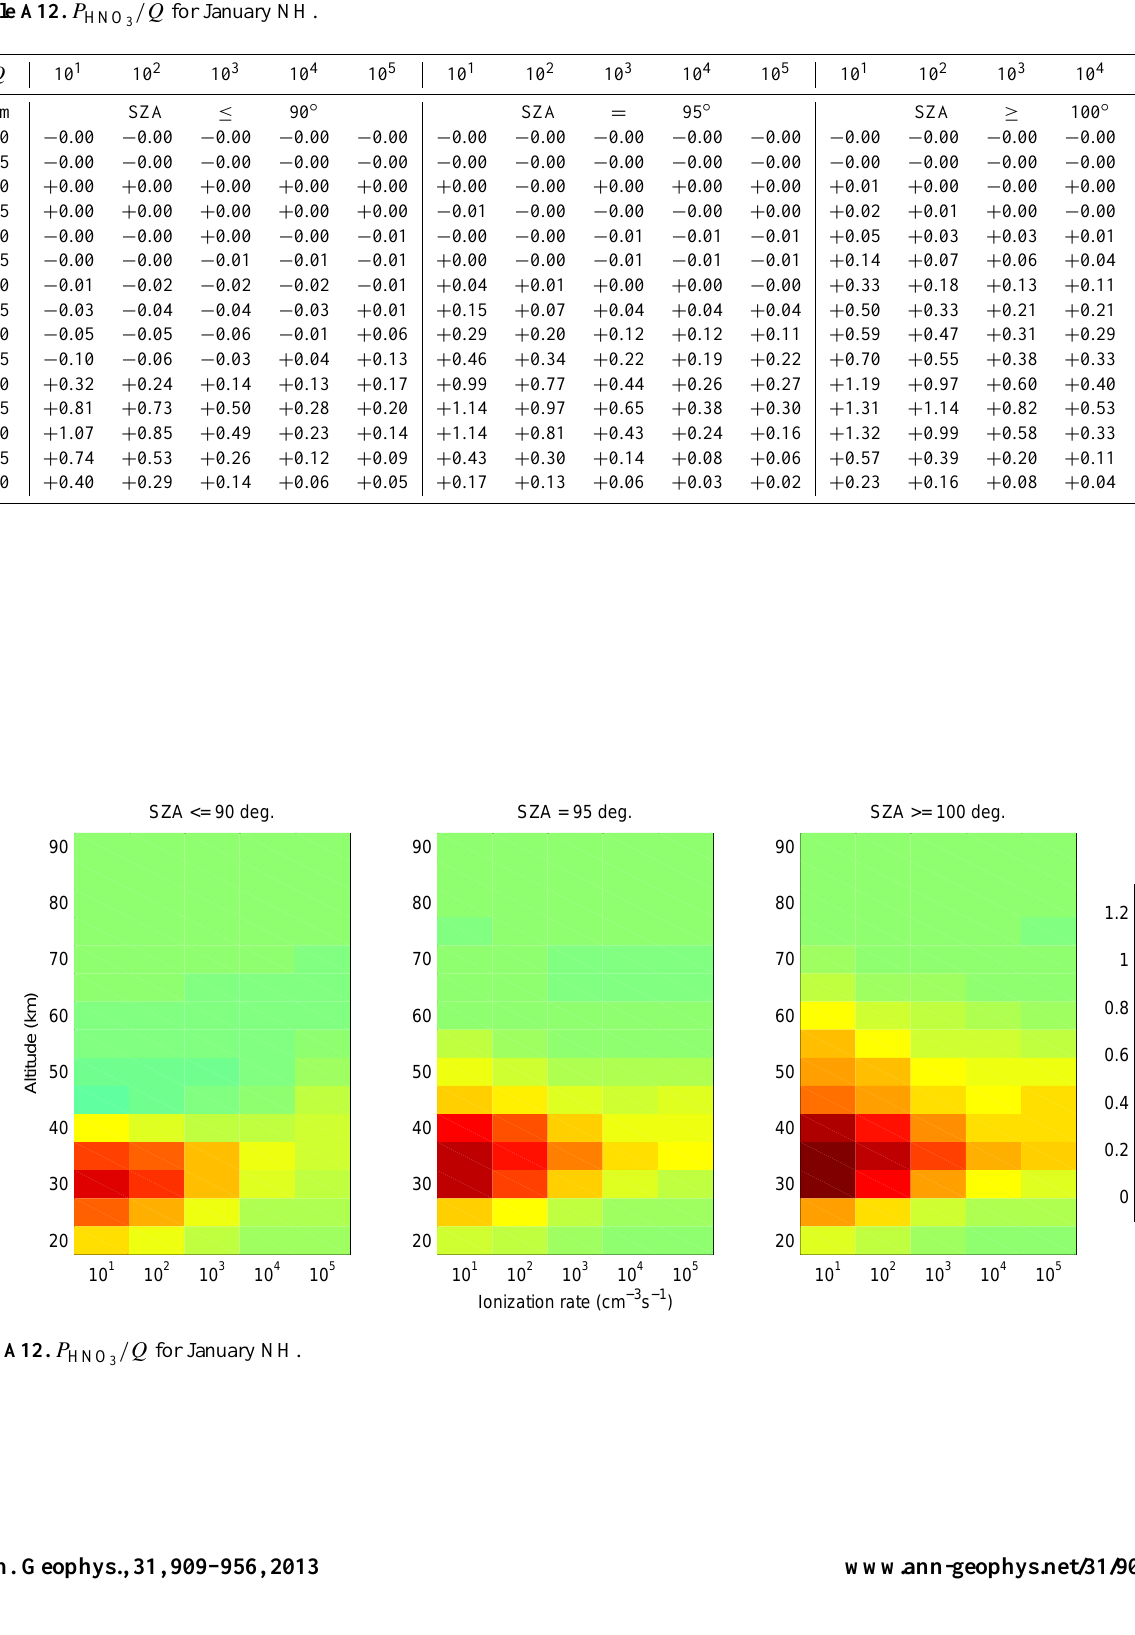
Table A12. P HNO